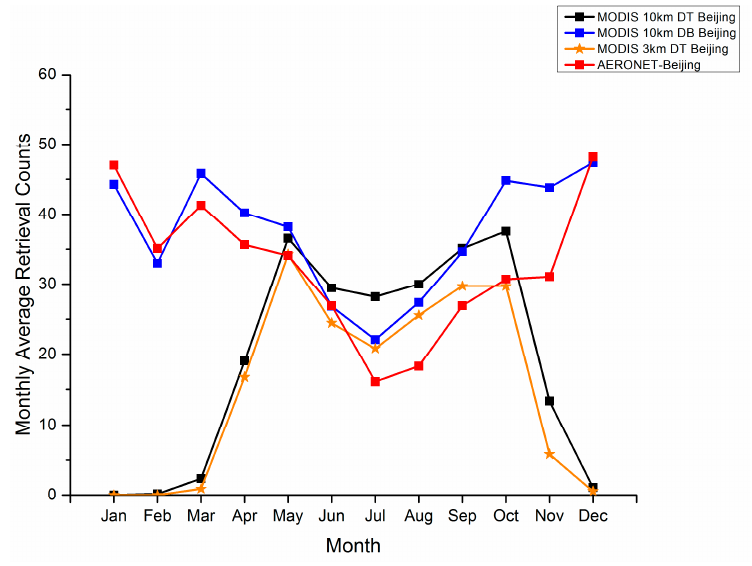
Figure 4. Validation of the MODIS (both Terra and Aqua) 3 km Dark Target AOD against AERONET measurements at the Beijing station, and Beijing-CAMS station.